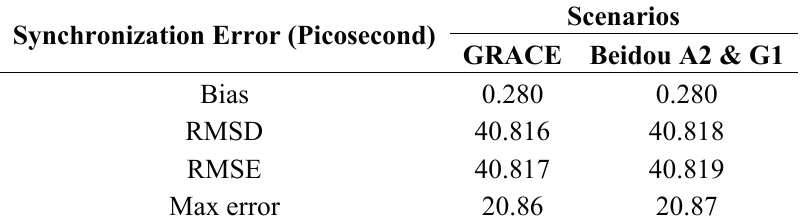
Table 5. Synchronization errors of the GRACE mission and Beidou A2 &